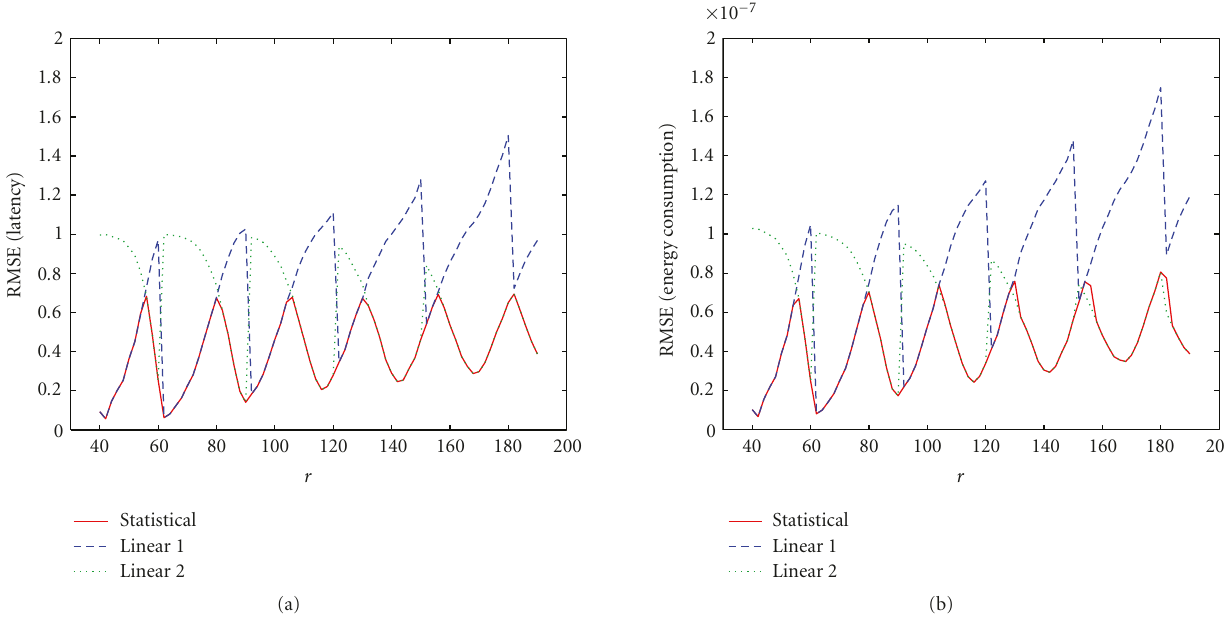
Figure 6: Estimation RMSE: (a) latency; (b) energy